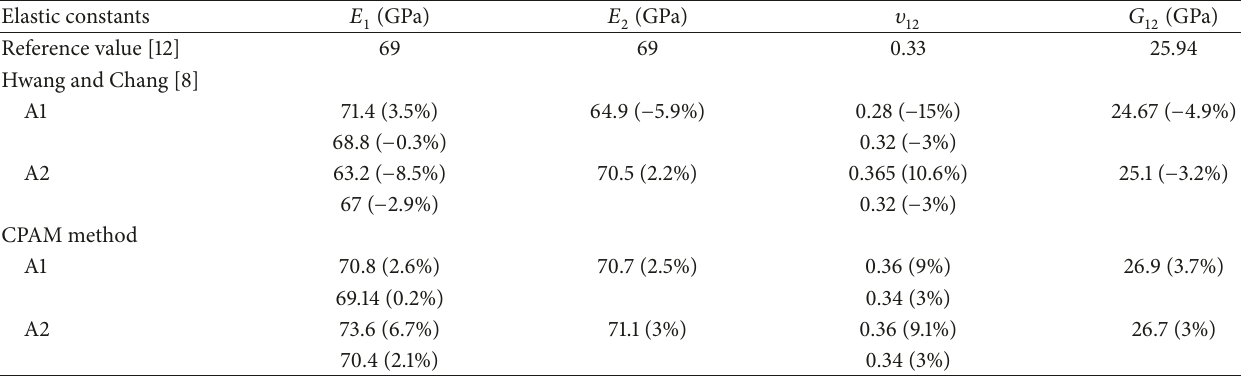
Table 8: Elastic constants determined for the aluminum specimens.